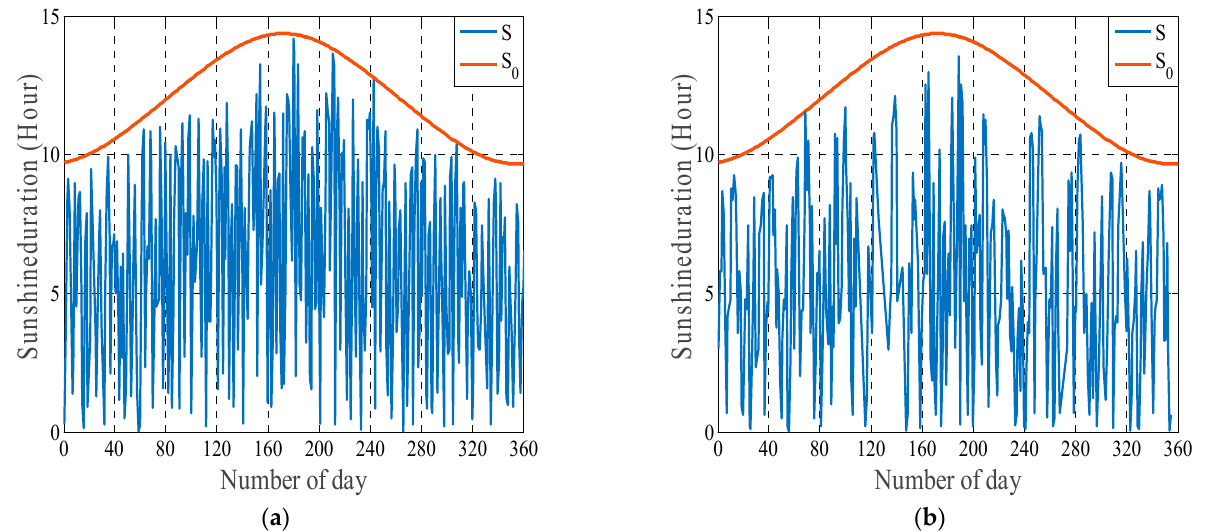
Figure 1. The daily variations of the maximum (theoretical) and the measured sunshine. ( a ) Curves for Tlemcen site; ( b ) Curves for Senia site.